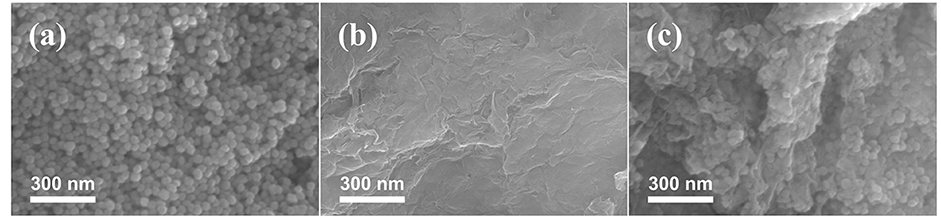
Figure 2. FE-SEM images of ( a ) α -Fe 2 O 3 , ( b ) RGO, ( c ) α -Fe 2 O 3 /RGO. TEM studies of the α -Fe 2 O 3 /RGO composites were performed to define their micro- structure further (Figure 3). Figure 3a shows that α -Fe 2 O 3 solid nanoparticles ranging in size from 20 to 50 nm are evenly dispersed over RGO. This result also reveals efficient assembly of the α -Fe 2 O 3 particles and graphene sheets during the hydrothermal treatment. The 0.22 nm lattice spacing in the (113) plane identifies the α -Fe 2 O 3 particles (Figure 3b)